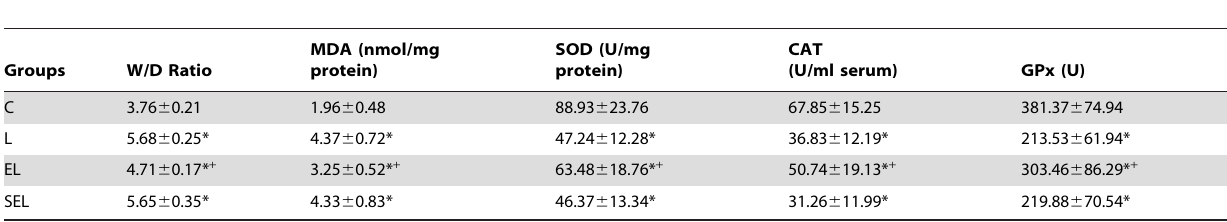
Abbreviations : W/D, wet to dry weight ratio; MDA, malondialdehyde; SOD, superoxide dismutase; CAT, catalase; GPx , glutathione peroxidase. Values as means 6 SD (n=10).